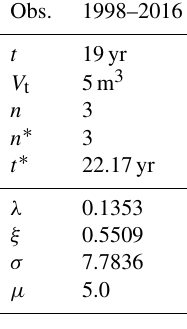
Table 4. Input and results of the analyses performed on the Becco dell’Aquila site. The estimates of the parameters of the distribution are reported in the bottom rows (the standard deviations are detailed into brackets). Obs.